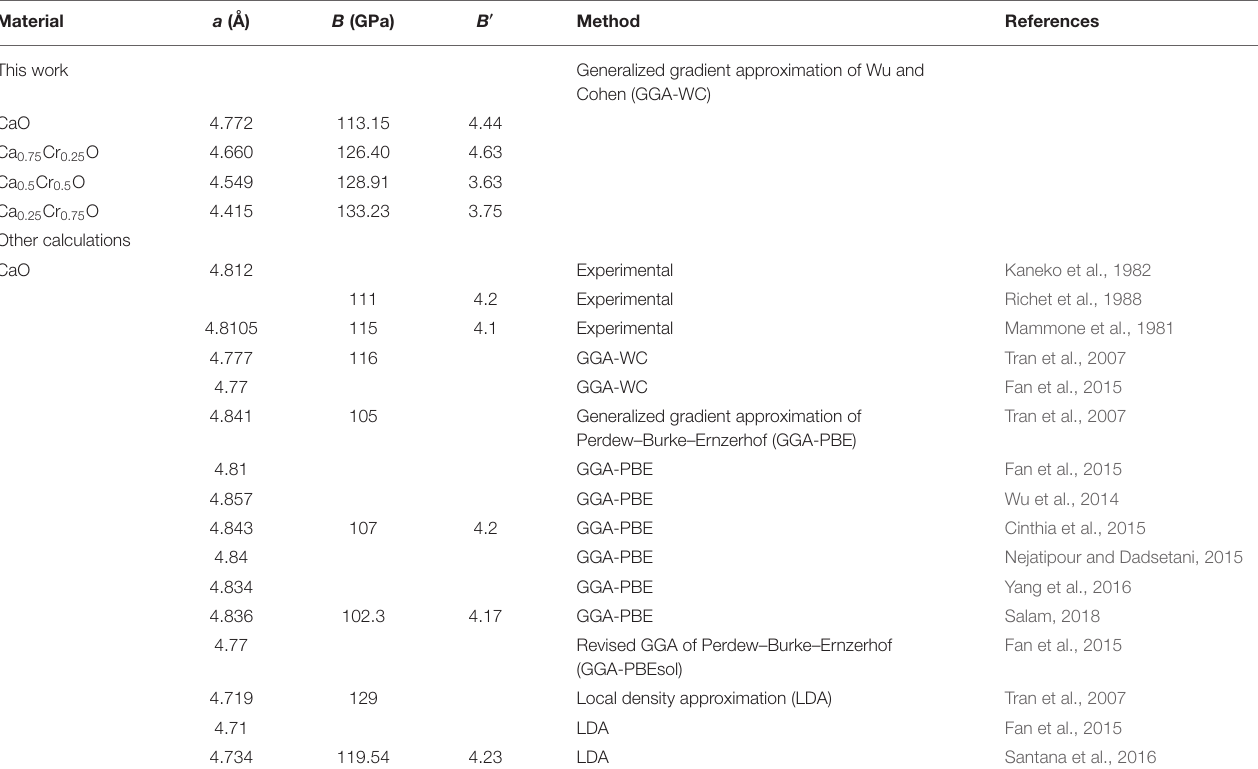
TABLE 1 | Computed structural parameters such as lattice constants ( a ), bulk modules ( B ), and their pressure derivatives ( B ′ ) for Ca 1-x Cr x O materials at concentrations x = 0, 0.25, 0.5, and 0.75 with other experimental and theoretical data.